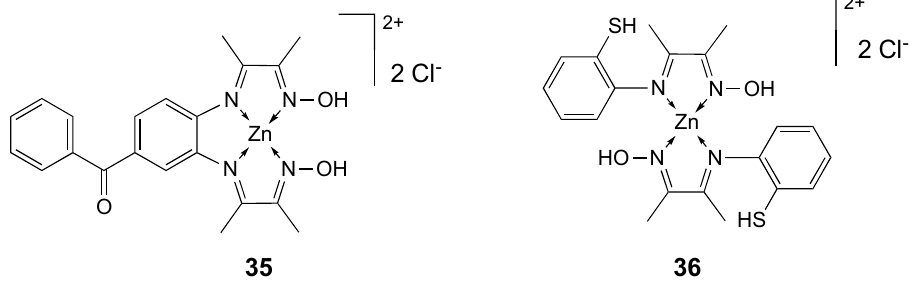
Figure 19. Structure of the zinc complexes 35 and 36 .